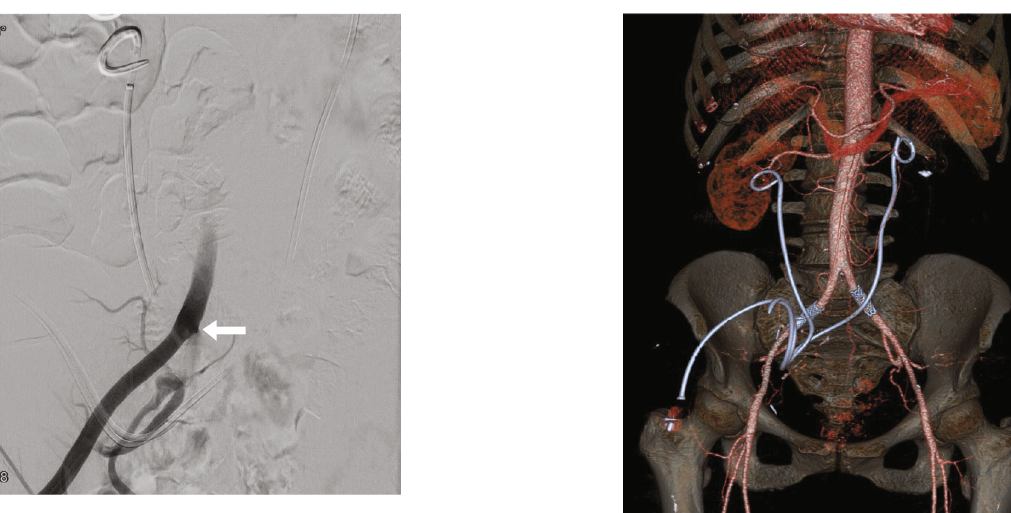
Figure 1: Intra-arterial angiography in digital technique showed a fi stula between the common iliac artery and the ureter.